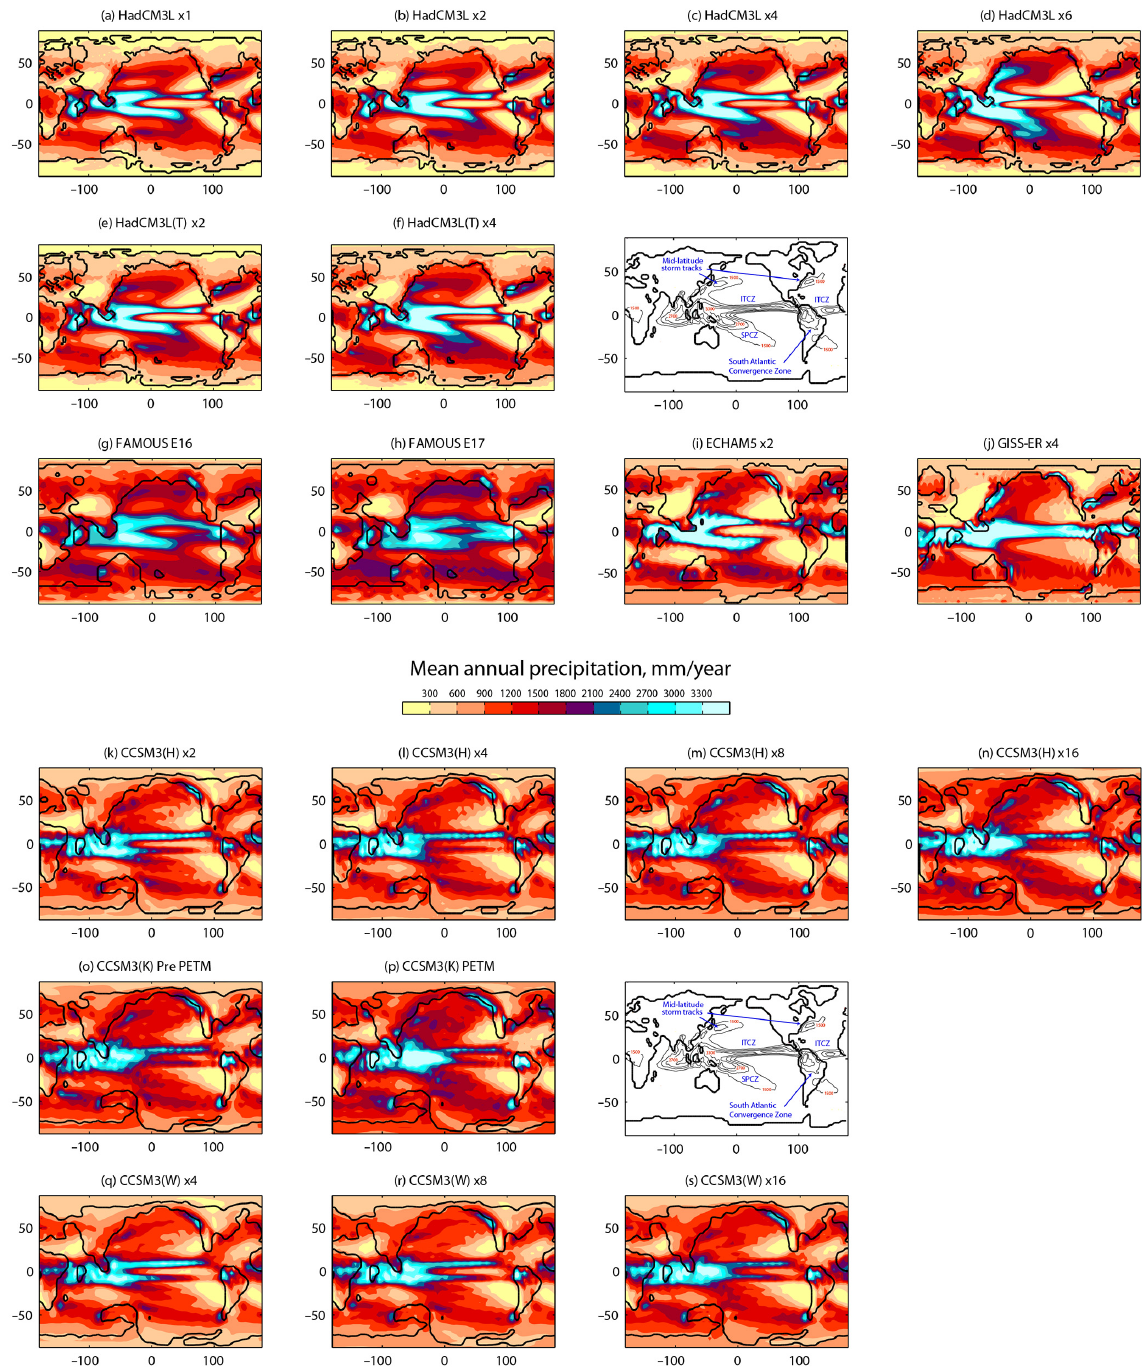
Figure 3. Mean annual precipitation distributions for each member of the EoMIP ensemble in millimetre per year (early Eocene paleogeog- raphy; ∼ 55Ma). CO 2 for each model simulation is shown above each plot. The FAMOUS simulations are both at x2 CO 2